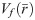
Effects of tuning fiber volume fraction.(a) Optimal fiber distribution, Vf(r¯), for various conditions of Vfav. (b) Maximized flexural rigidity, Dc and the improvement ratio in the rigidity, η.